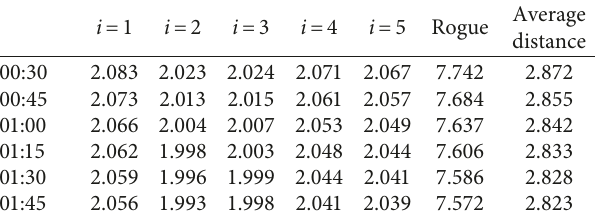
Table 2: Average Euclidean distances of SS of lawful and moving rogue